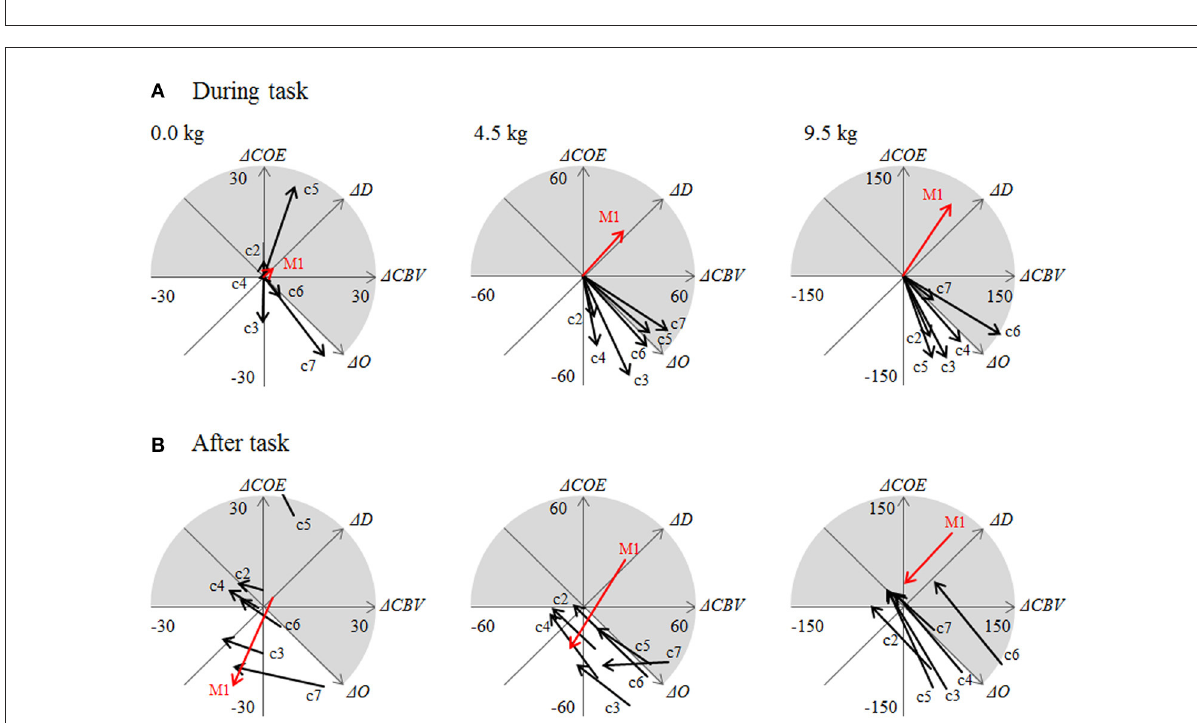
FIGURE4 Functional images of three indices ( k , L , and Area kL ) during tasks.